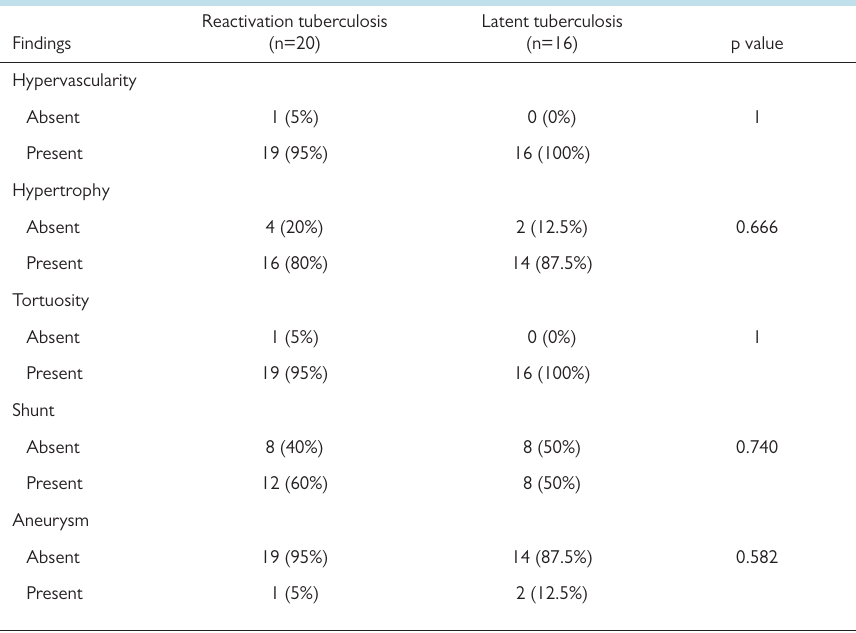
Table 2. Angiographic findings of tuberculosis patients